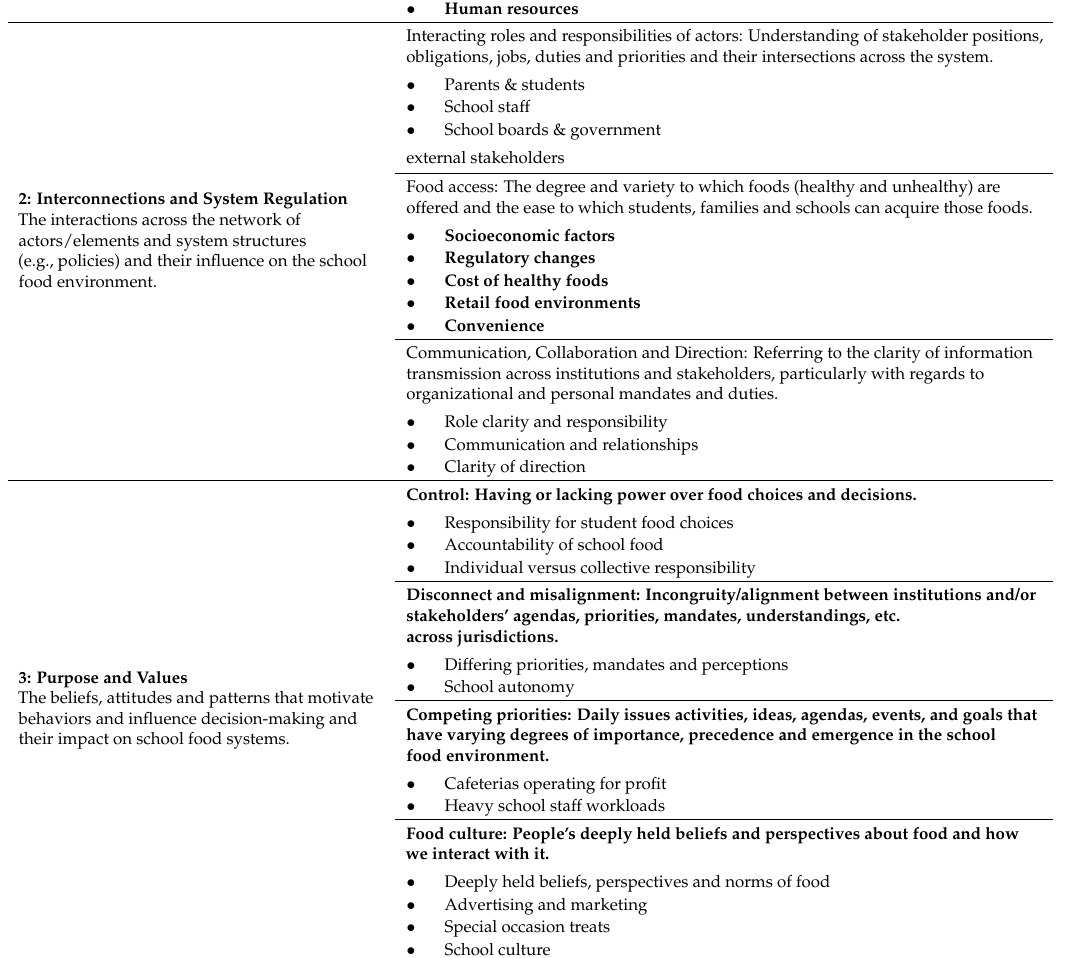
1: Actors and Elements The human, material and monetary resources present or lacking in the school food system, as identified by